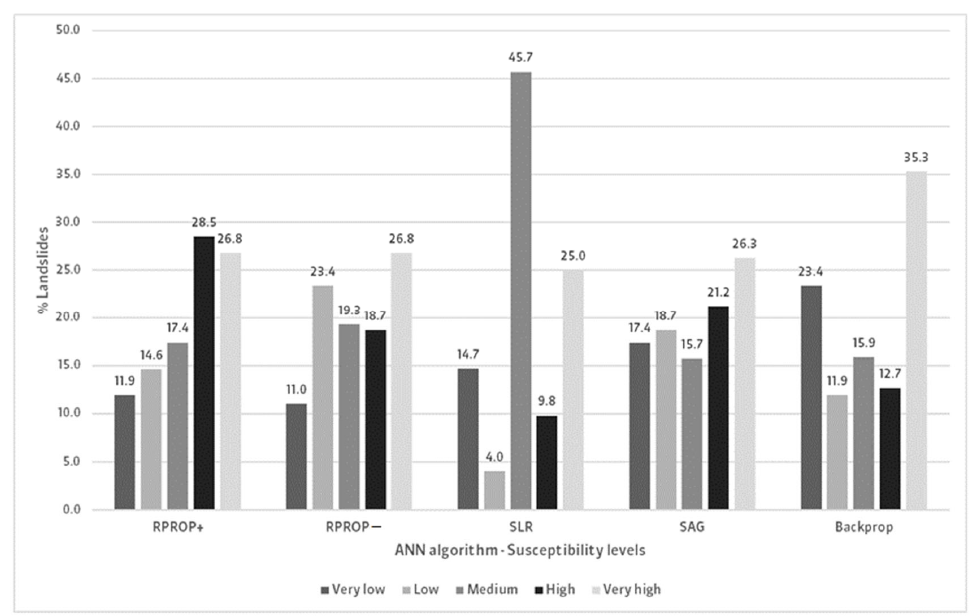
Figure 9. Distribution of susceptibility classes per each landslide susceptibility map.